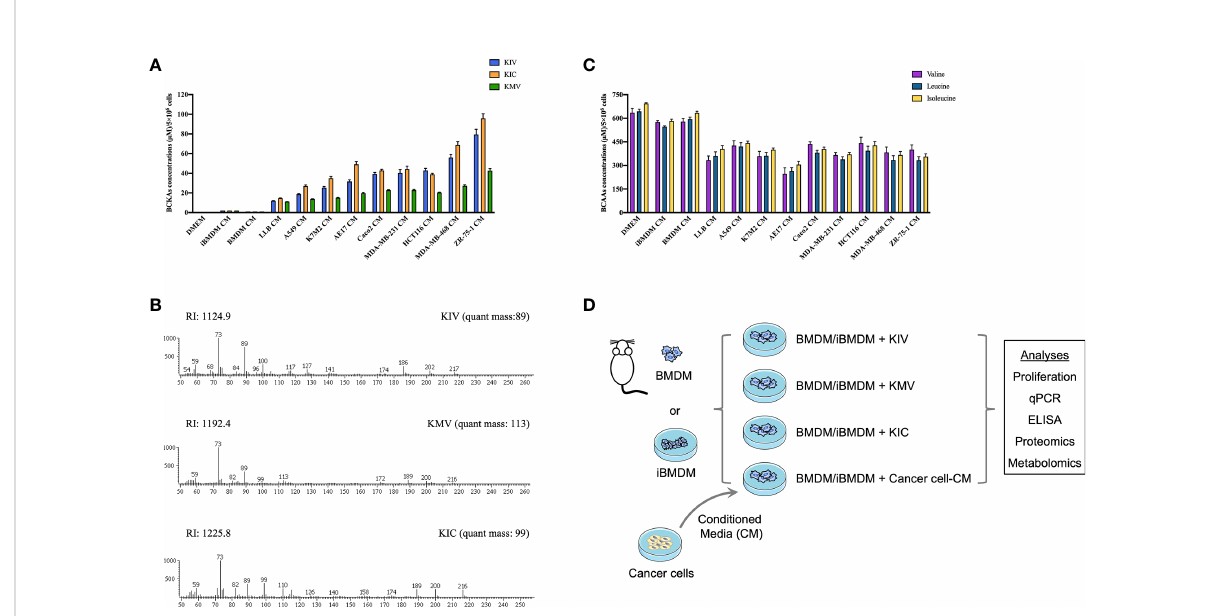
FIGURE 1 Cancer cells consume BCAAs and secrete BCKAs. (A) , BCKAs (KIV, KIC and KMV) in the DMEM complete medium or conditioned media (CM) from indicated cells were detected by GC-MS. (B) , Representative mass spectra of KIV, KIC and KMV by GC-MS. (C) , BCAAs (leucine, isoleucine and valine) in the DMEM complete medium or conditioned media from indicated cells were detected by GC-MS. (D) , Diagram of work fl ow. Conditioned media from cancer cells and three BCKAs were added to BMDM or iBMDM, followed by multiomics analysis. Data in A and C show the mean ± SEM of n = 3 technical